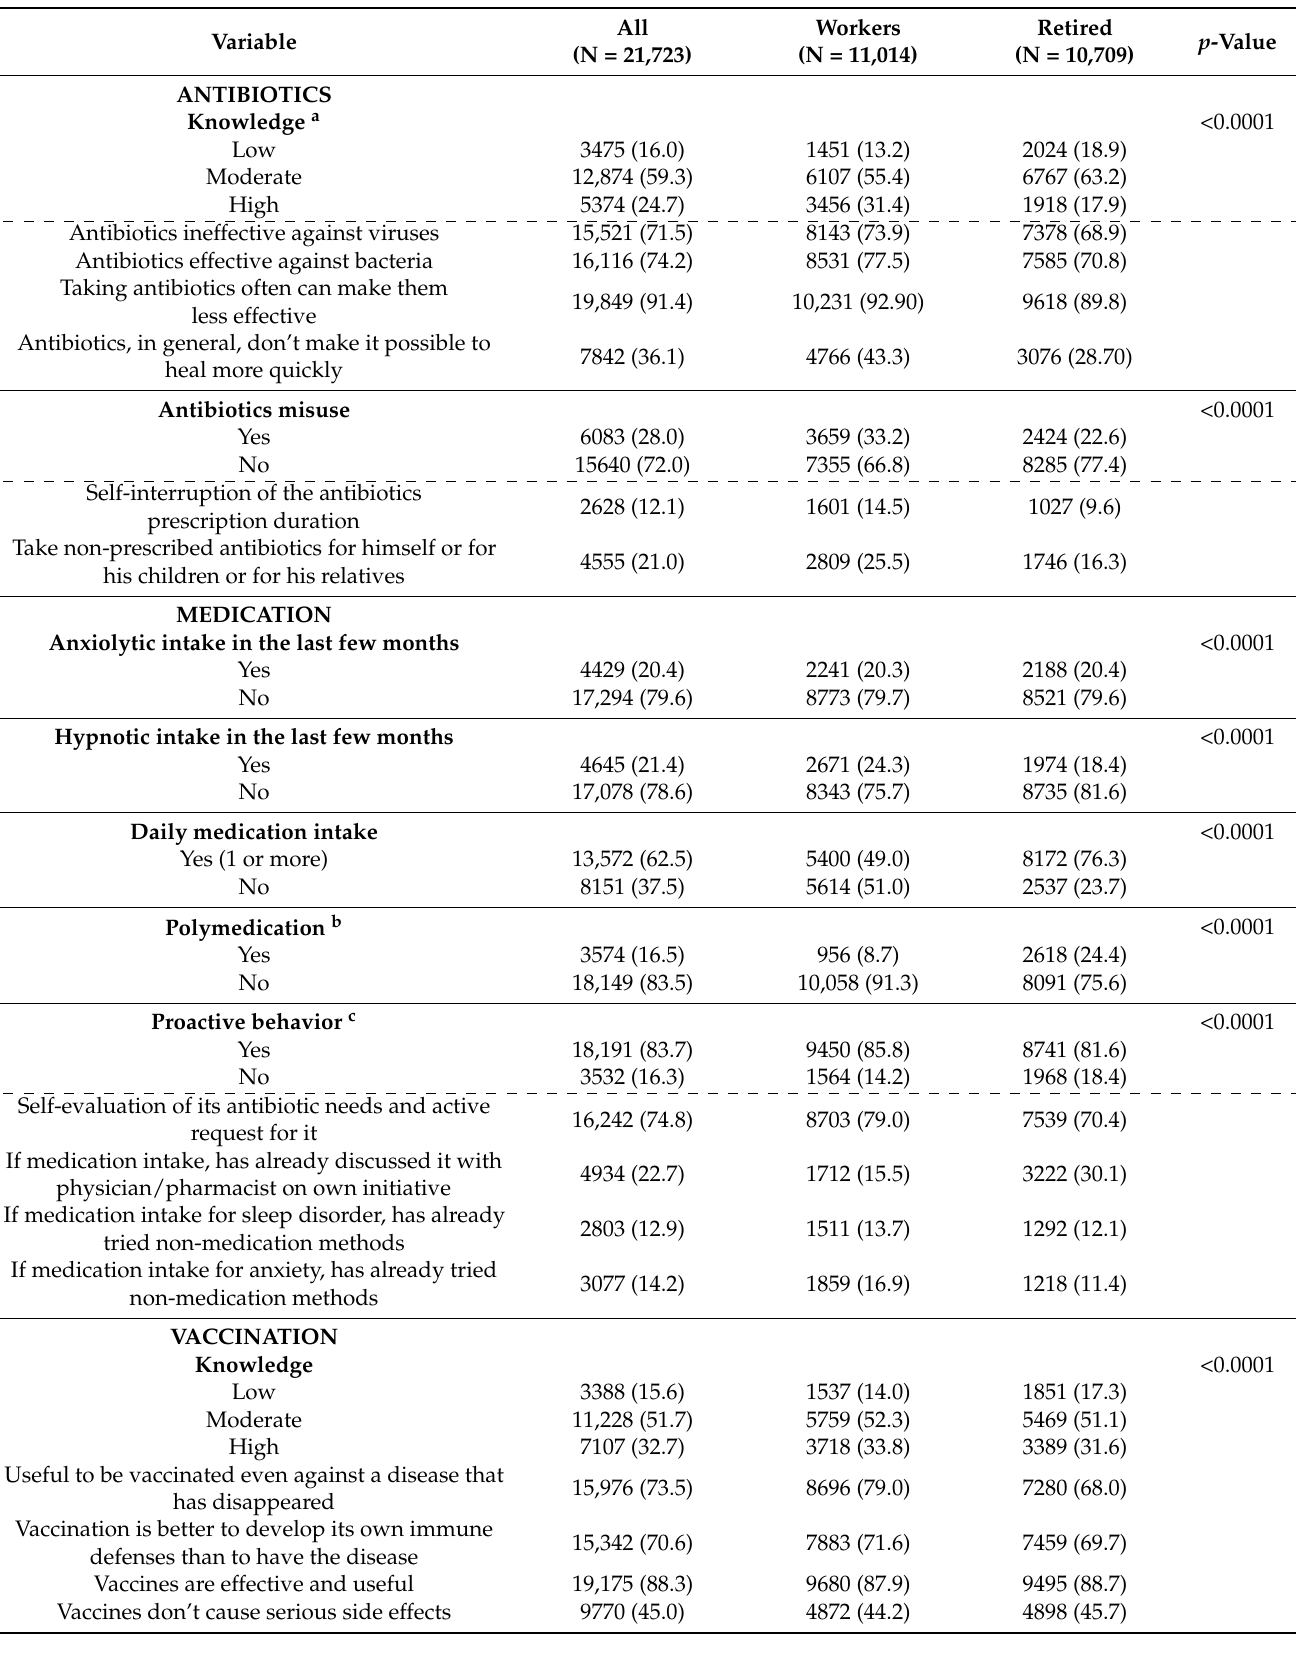
Table 2. Knowledge, attitudes and practices related to antibiotics, medication and vaccination among public service workers and